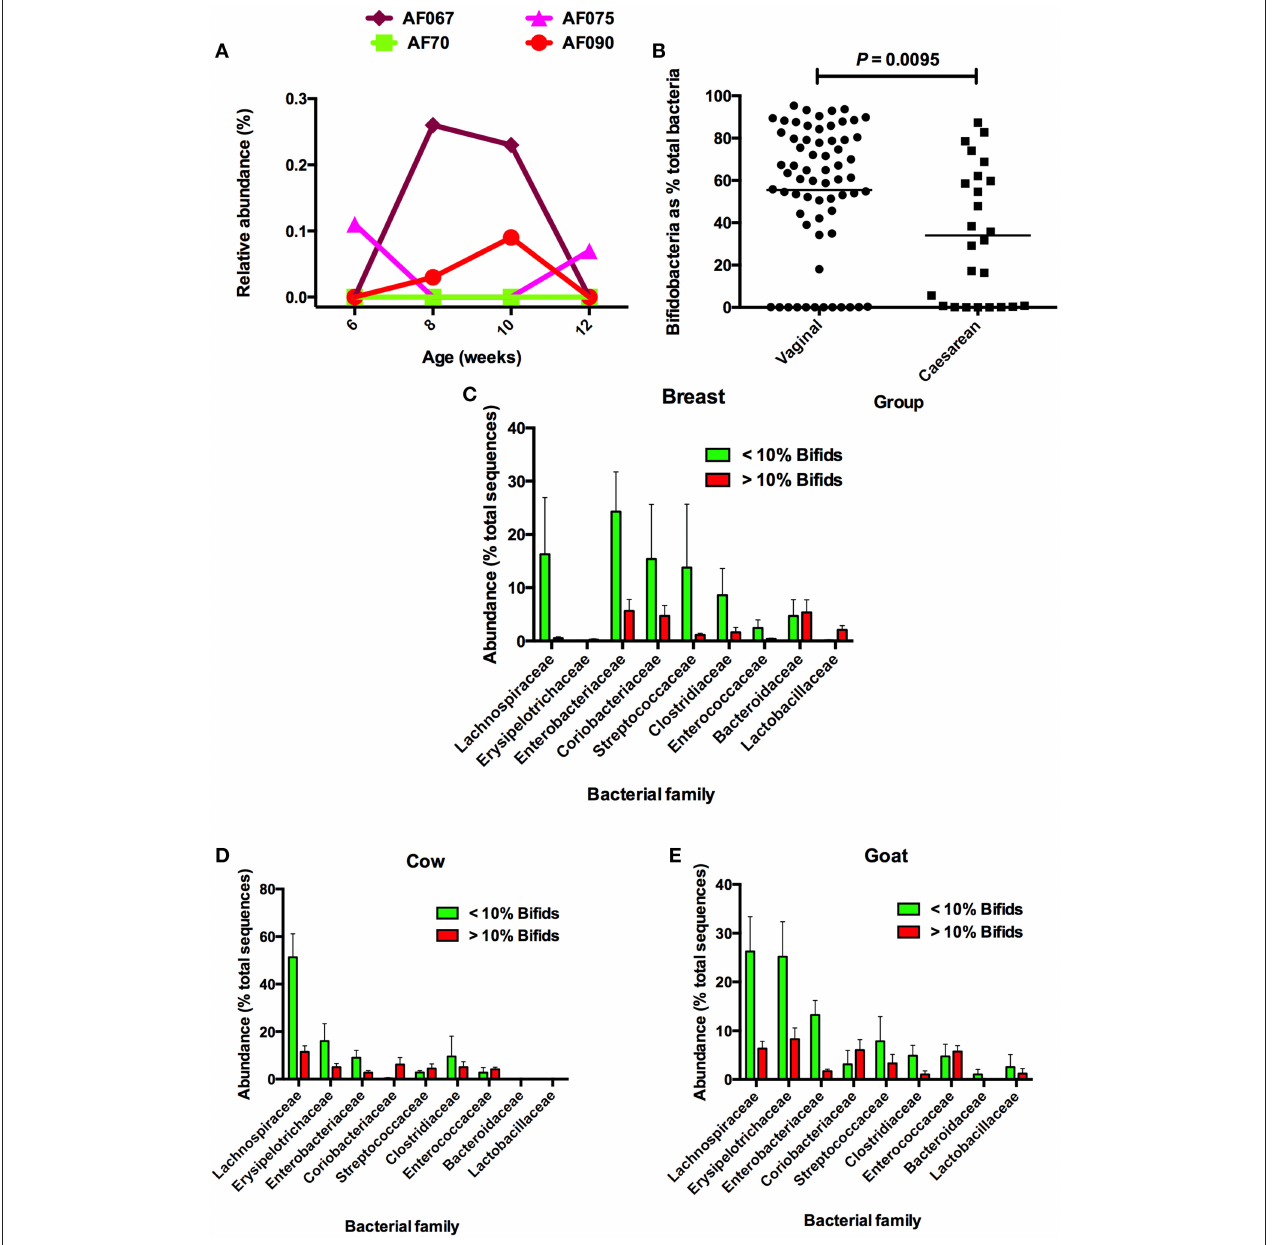
FIGURE 1 | (A) Examples of babies without bifidobacteria, or very low abundances of bifidobacteria, in feces during the first 12 weeks of life. Bifidobacteria were undetectable by DNA sequencing of 16S rRNA gene amplicons at 6 and 12 weeks in the feces of AF067; 6, 8, 10, and 12 weeks in AF70; 8 and 10 weeks in AF075; and 6 and 12 weeks in AF090. (B) Comparison of bifidobacerial abundances in the feces of infants delivered vaginally or by cesarean. Note that in both groups, bifidobacteria were not detected in some infants. (C) Comparison of abundances of bacterial families in microbiotas of breast milk-fed infants in relation to abundances of bifidobacteria. (D) Comparison of abundances of bacterial families in microbiotas of cow milk formula-fed infants in relation to abundances of bifidobacteria. (E) Comparison of abundances of bacterial families in microbiotas of goat milk formula-fed infants in relation to abundances of bifidobacteria. Note that Lachnospiraceae have increased abundances when bifidobacteria have low relative abundance. Figures after Tannock et al. (2013), reproduced with